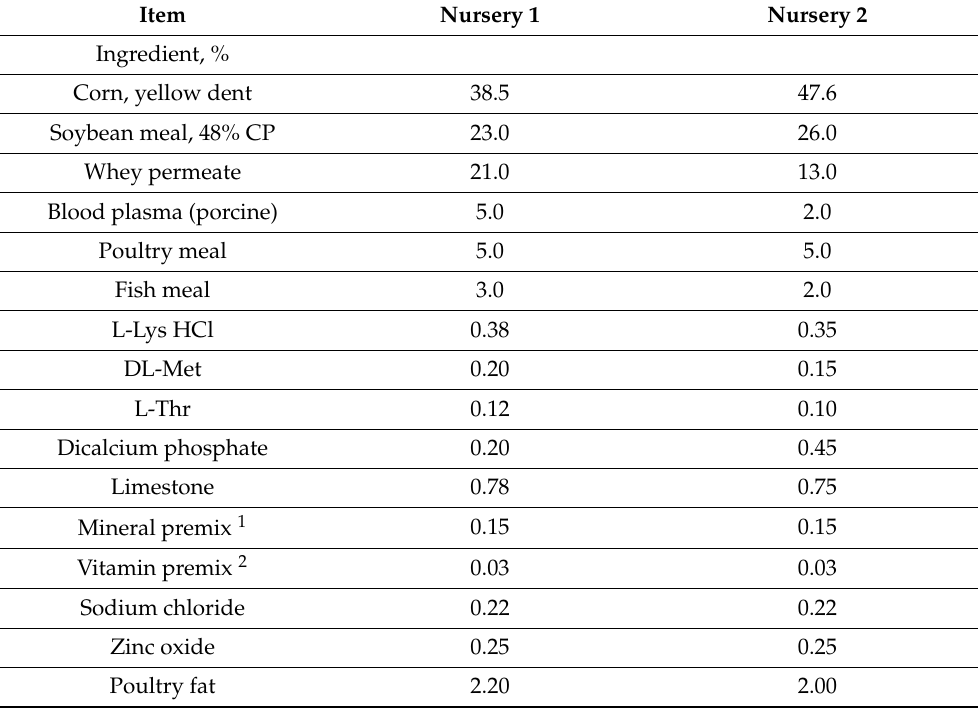
Table 1. Composition of basal diets (Exp. 1; as-fed basis). Item Nursery 1 Nursery